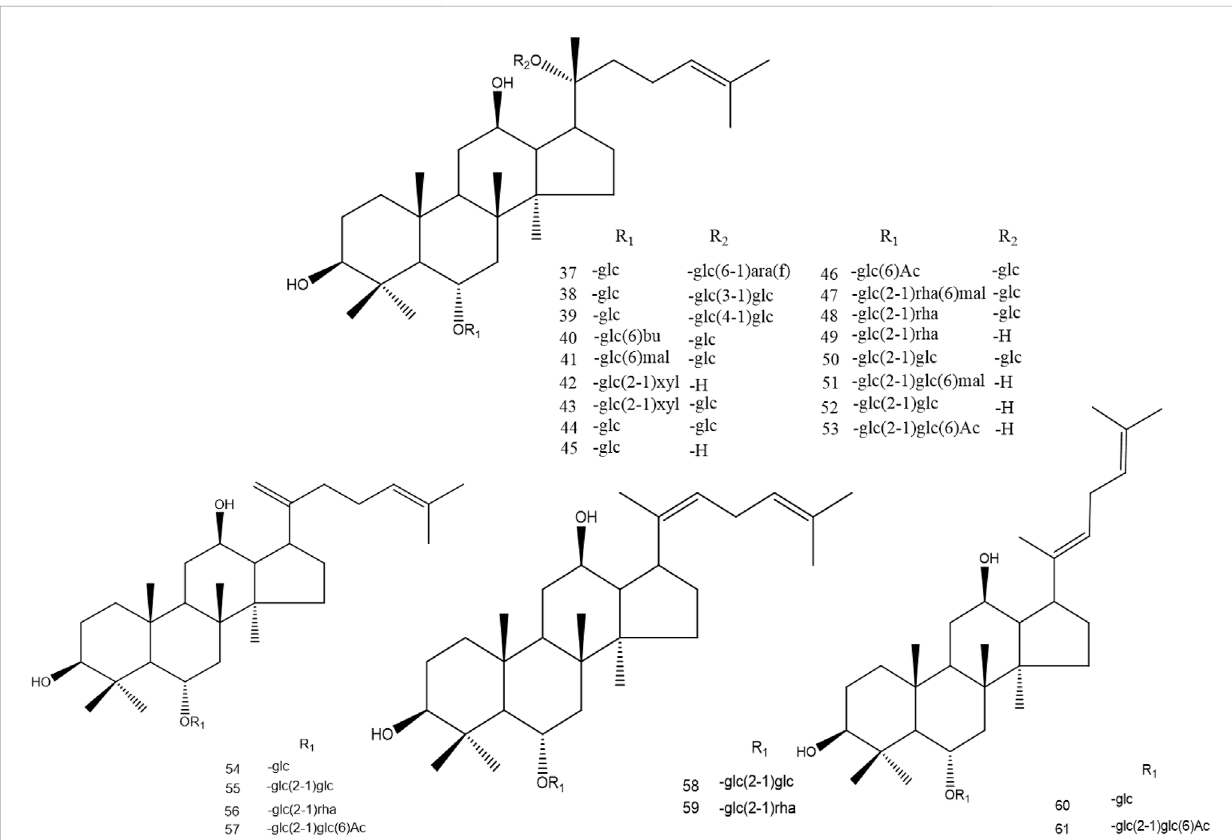
FIGURE 4 Structure of protopanaxatriol ginsenosides. (ara(f): α -L -arabinofuranosyl; rha: α -L -ahamnopyranosyl; glc: β -D -glucopyranosyl; xyl: β -D - xylopyranosyl; mal:malonyl; bu:butyl;